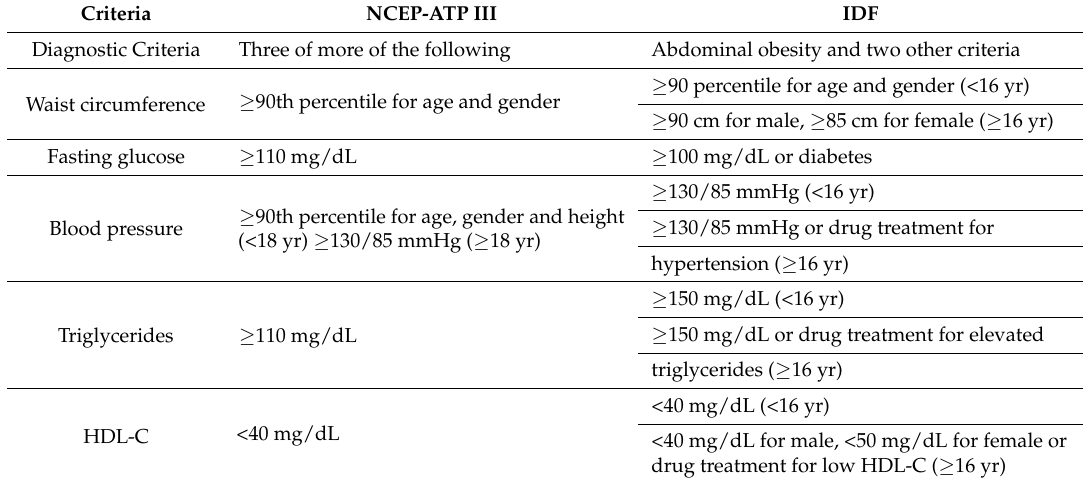
Table 1. Metabolic syndrome diagnostic criteria for an adolescent